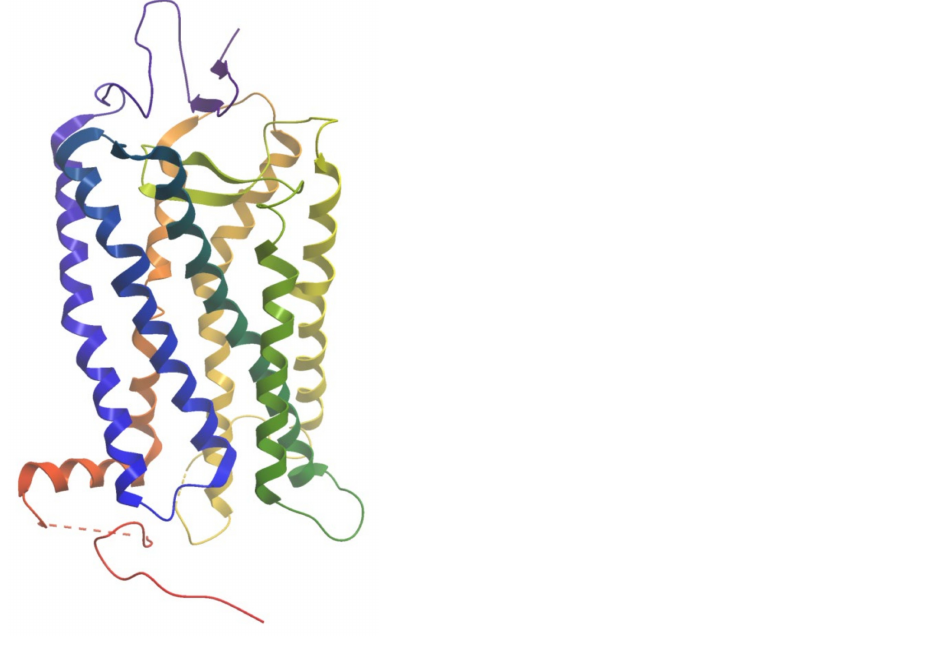
Figure 1. The structure of bovine rhodopsin (PDB ID: 1F88). The helices are colored from N-terminus (blue) to C-terminus